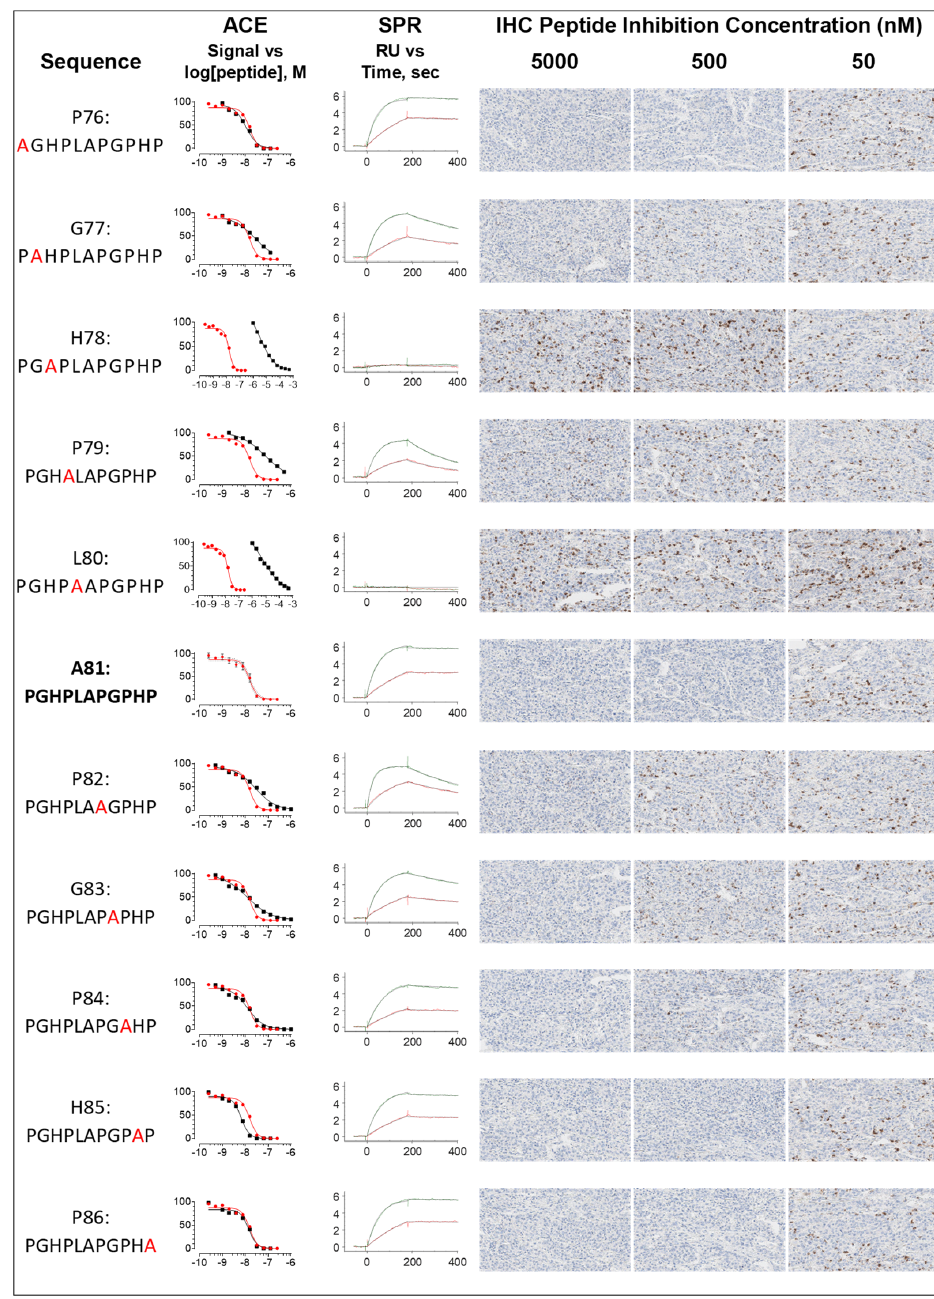
Figure 4. Fine epitope mapping of the SP464 target sequence by alanine substitution using ACE, SPR and IHC. Column 1 shows the substituted amino acid and its position in the full-length protein sequence, with the alanine substitution in red. Column 2 provides the ACE data dose response curves for concentrations of peptides covering several orders of magnitude. For these plots, each alanine substitution curve (black squares) is graphically compared to the wildtype curve (red circles). Column 3 contains the SPR response plots showing the signal from the two tested concentrations of peptide, 100 nM (green) and 20 nM (red). The final columns show IHC images of peptide inhibition in a tissue section of hepatocellular carcinoma at the provided concentrations. Image shown represents a 300 by 500 square micron tissue region with an apparent magnification of 20×.